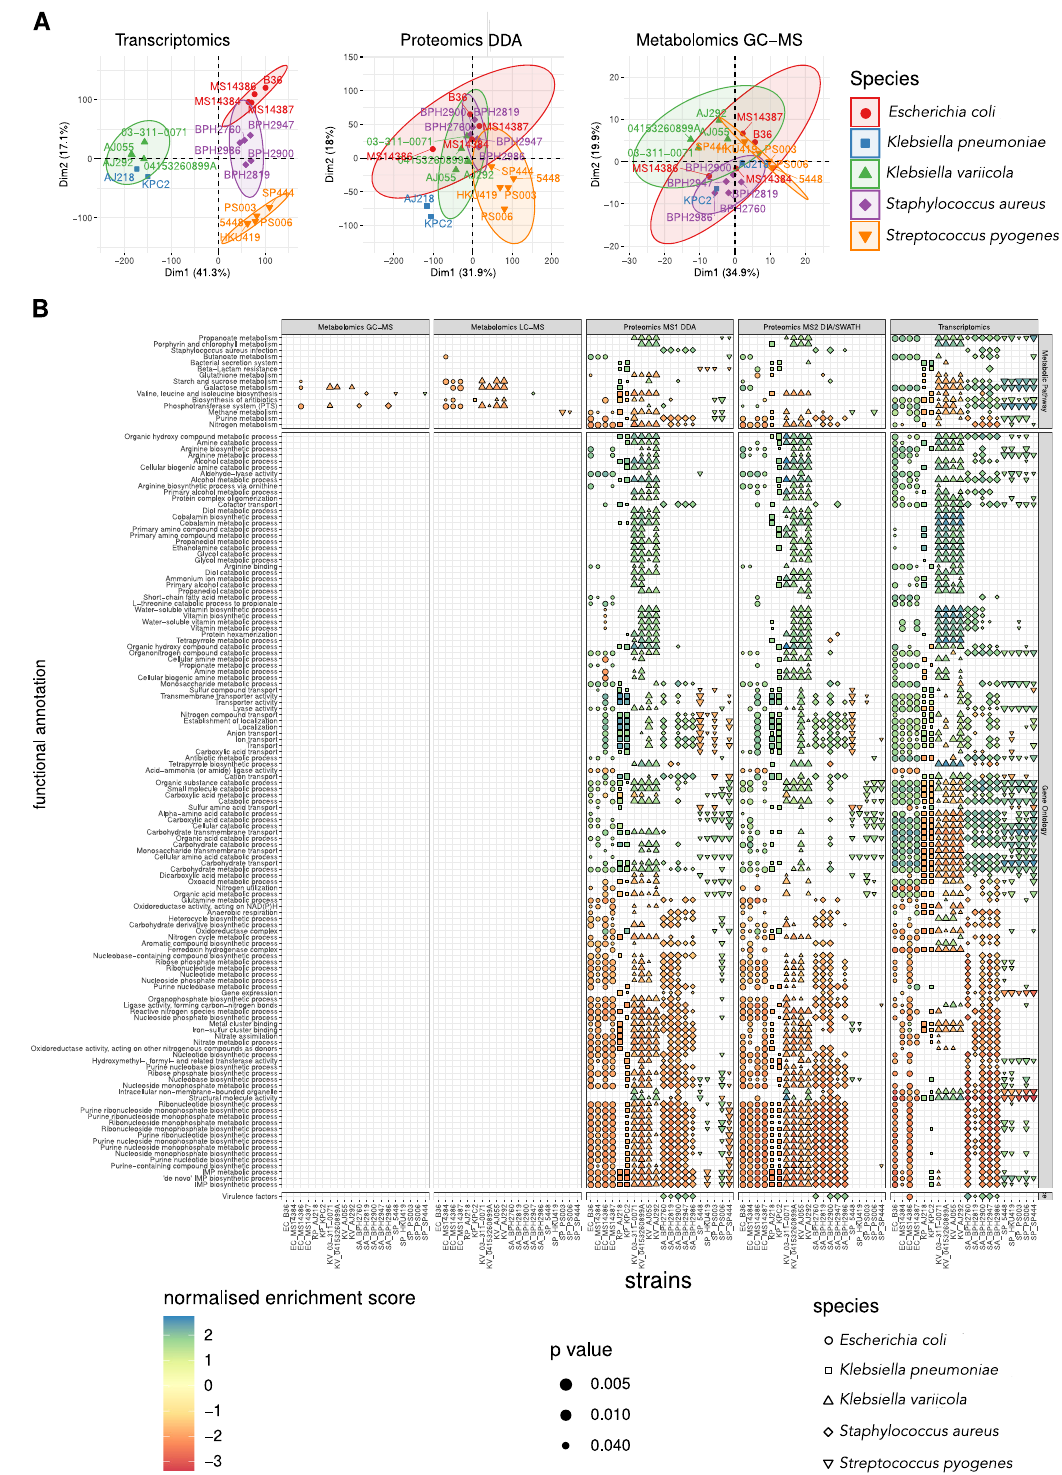
Fig. 7 | Functional and metabolic pathway enrichment analysis to assess the multi-omics response to serum. A Principal component analysis representing the proximity of the functional responses to human serum exposure. The data compile the response of the 20 bacterial strains by transcriptomics, proteomics and metabolomics. B Dot heatmap representing the shared enrichment of GO terms and KEGG pathways across all strains and the different omics. Shapes and